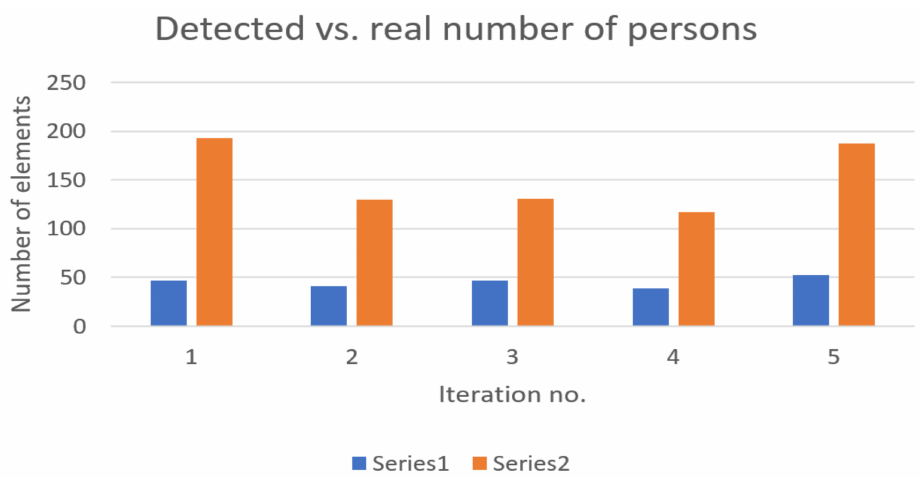
Figure 6. Detected devices (represented in blue—Series 1) versus real number of persons (represented in orange—Series 2) present on platforms—one train in station (Subway Station 2).